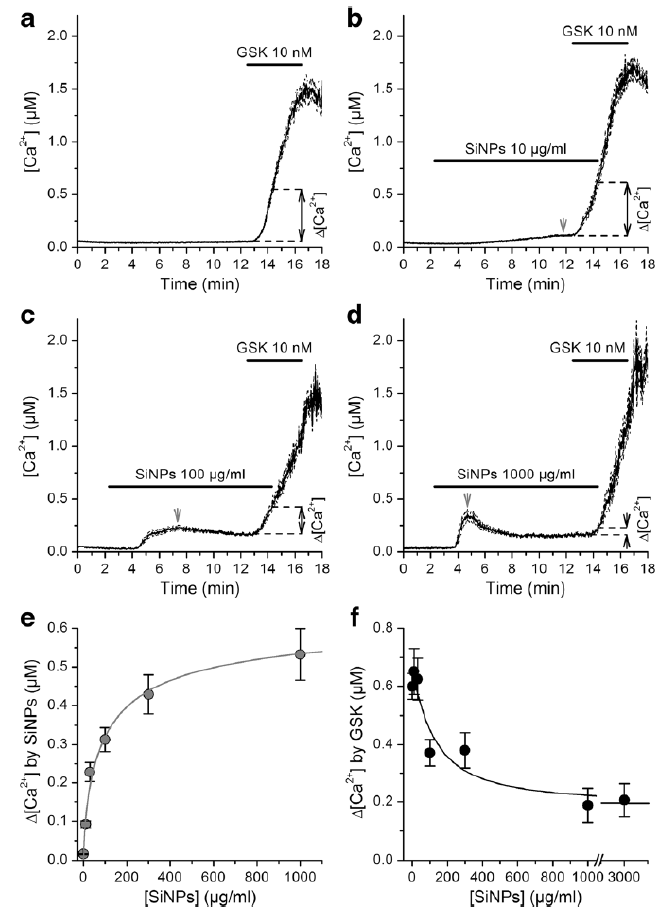
Figure 2. Amorphous silica nanoparticles inhibit the chemical activation of TRPV4. Acute response elicited in cultured human airway epithelial (16HBE) cells by different concentration of 10 nm amorphous silica nanoparticles (SiNPs) and the corresponding TRPV4 inhibition (( a ): 0 μg/mL, ( b ): 10 μg/mL, ( c ): 100 μg/mL, ( d ): 1000 μg/mL). ( e ) The influx in Ca 2+ upon SiNPs challenging is con- centration-dependent. ( f ) The inhibition of TRPV4 activation by agonist in the presence of SiNPs is concentration-dependent. Reproduced with permission from [24].